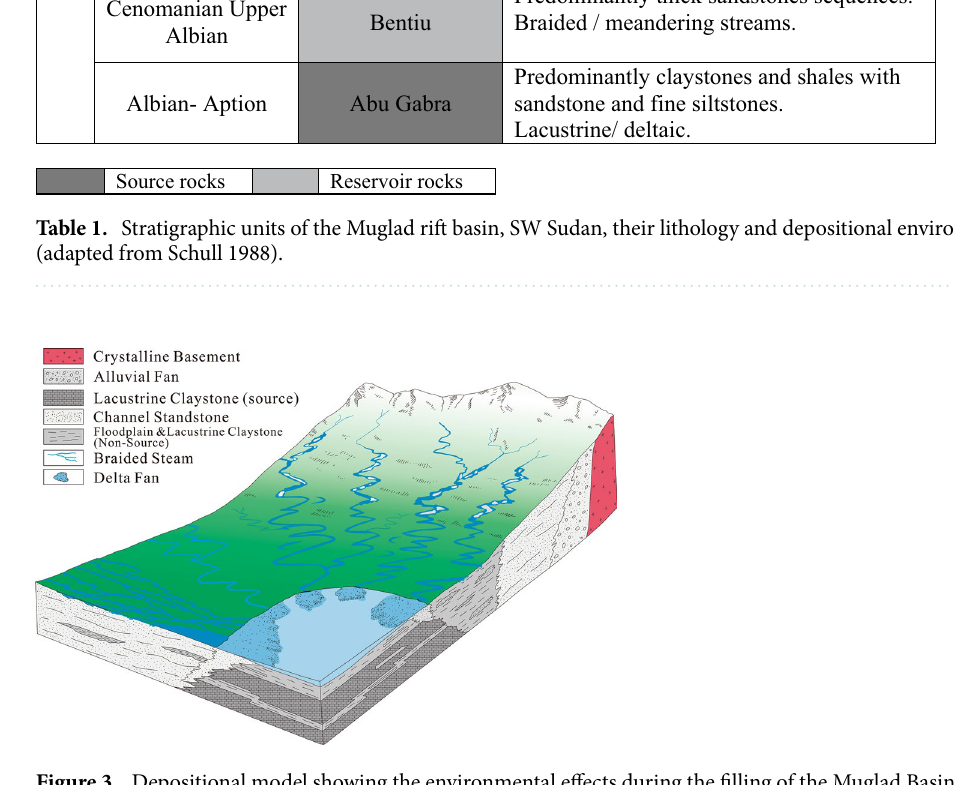
Figure 3. Depositional model showing the environmental effects during the filling of the Muglad Basin (created from information in reference 1